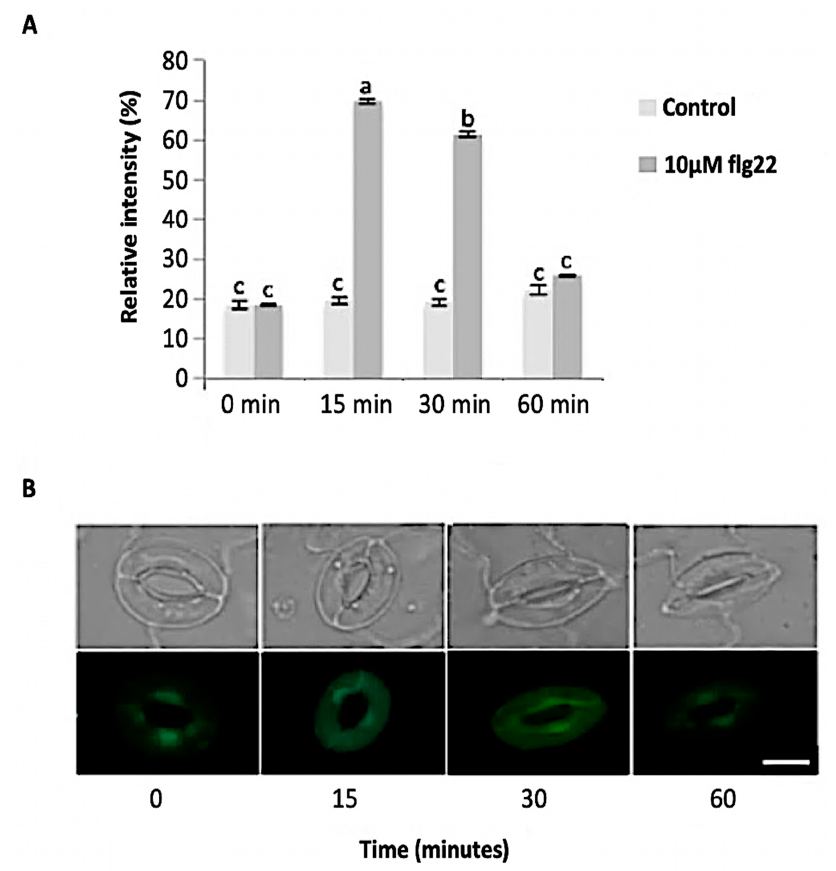
Figure 3. Reactive oxygen species (ROS) sproduction in guard cells in response to 10 µM flg22. ( A ) ROS levels measured from a total of 180 stomata from three independent experiments and presented as means ± SE. Different letters indicate significantly different mean values at p < 0.05. ( B ) Representative images of stomatal guard cells at each time point are shown. Scale bar: 10 µm.